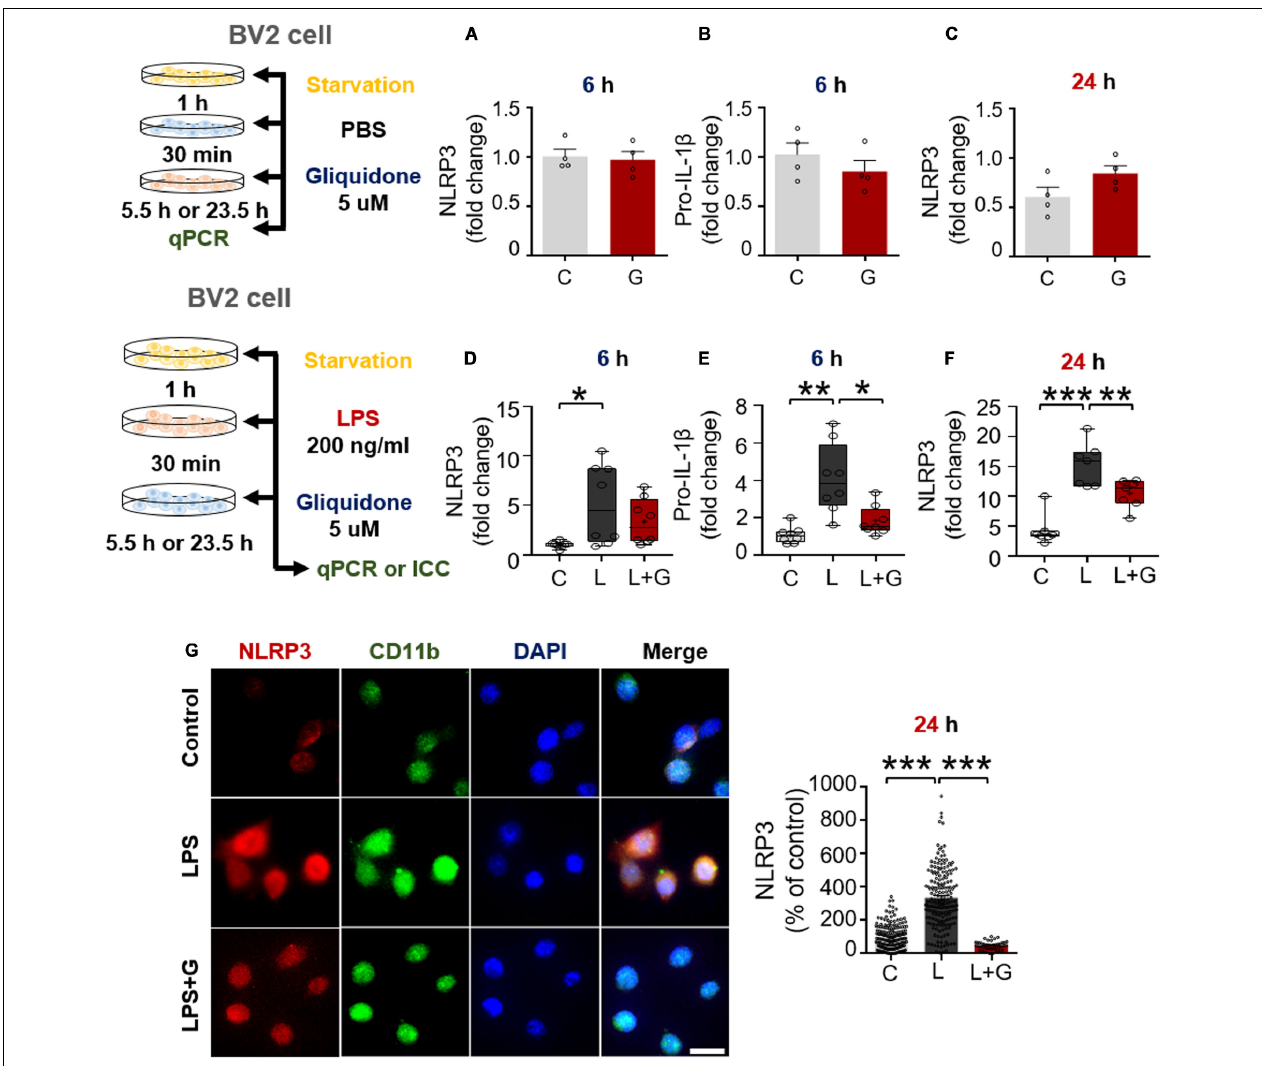
FIGURE 8 | Gliquidone inhibits LPS-stimulated NLRP3 and pro-IL-1 β in BV2 microglial cells. (A–C) Real time-PCR (q-PCR) analysis of NLRP3 and pro-IL-1 β mRNA levels in cells treated with gliquidone alone or vehicle for 5.5 or 23.5 h ( n = 4/group). (D–F) q-PCR analysis of NLRP3 and pro-IL-1 β mRNA levels in cells treated sequentially with LPS and gliquidone for 6 or 24 h (6 h NLRP3 and pro-IL-1 β , n = 8/group; 24 h NLRP3, n = 7/group). (G,H) Immunocytochemistry analysis of CD11b and p-NLRP3 levels in cells treated sequentially with LPS and gliquidone (C, n = 189; L, n = 198; LPS + gliquidone, n = 145). * p < 0.05, ** p < 0.01, *** p < 0.001. Scale bar = 20 µ